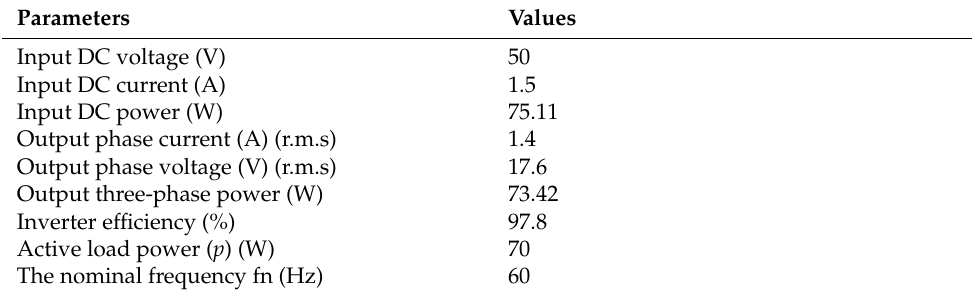
Table 5. Specifications for the hardware design and power rating of the